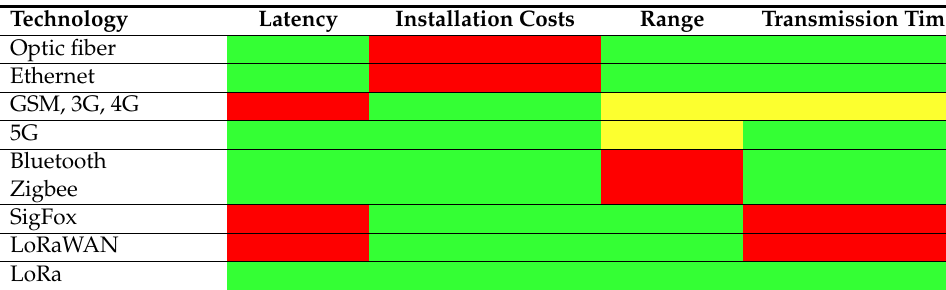
Table 1. Comparison of technologies that can be exploited for logic selectivity implementation. Green cell: complaint with logic selectivity implementation. Red cell: not complaint with logic selectivity implementation. Yellow cell: possibly not complaint with logic selectivity implementation (e.g., area not covered by mobile